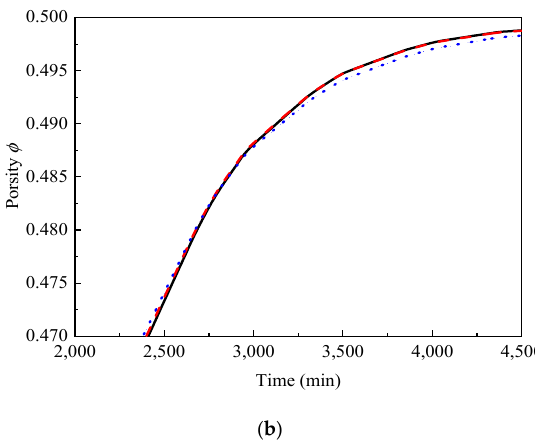
Figure 11. Evolution curves of porosity in saturated zone of railway subgrade: ( a ) evolution curves of porosity; ( b ) a detailed diagram of the curves in a box in ( a ).